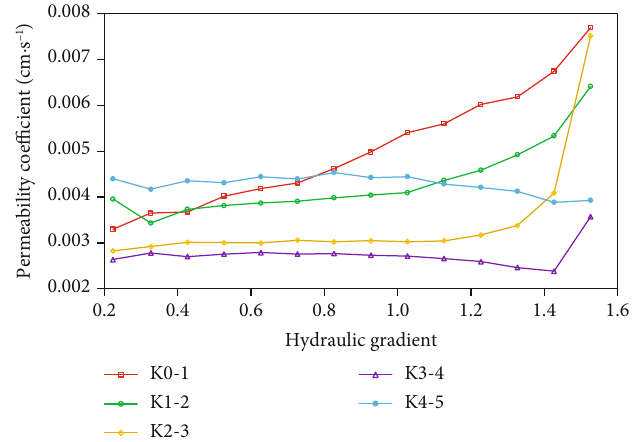
Figure 16: Process curve between hydraulic gradient and permeability of di ff erent parts in soil numbered 2.